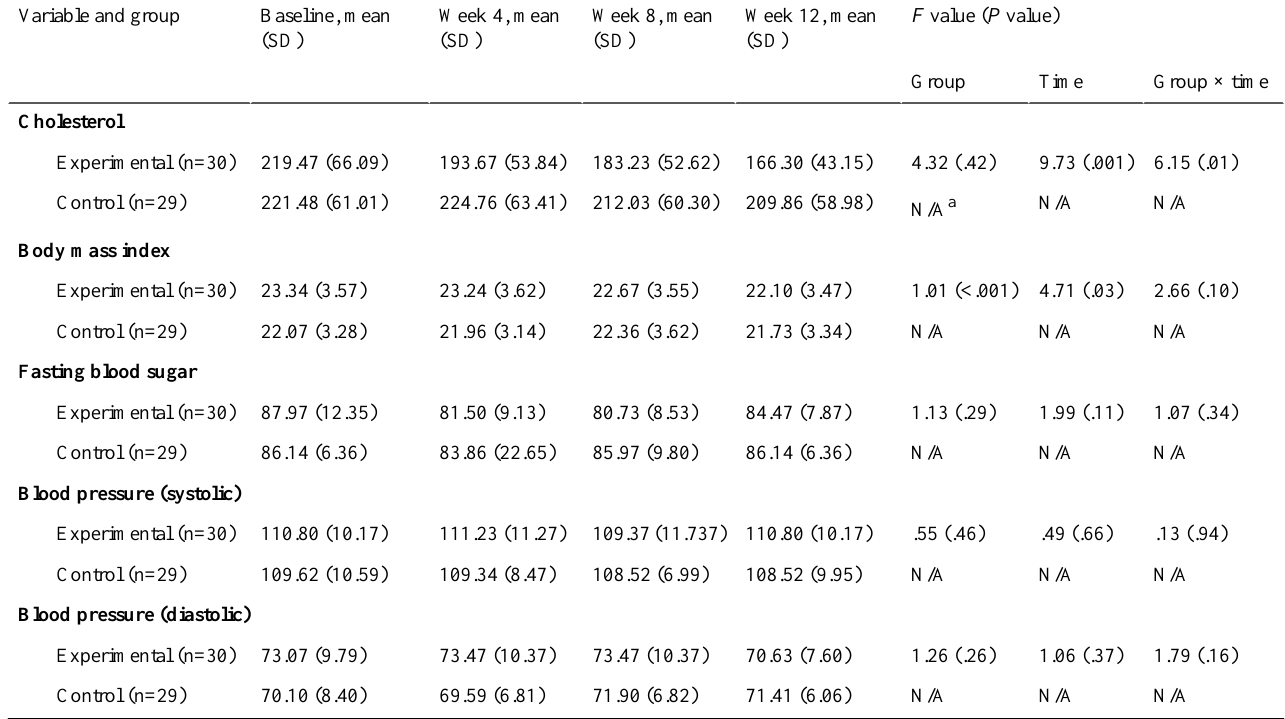
Table 2. Comparison of physical and physiological indicators between the experimental and control